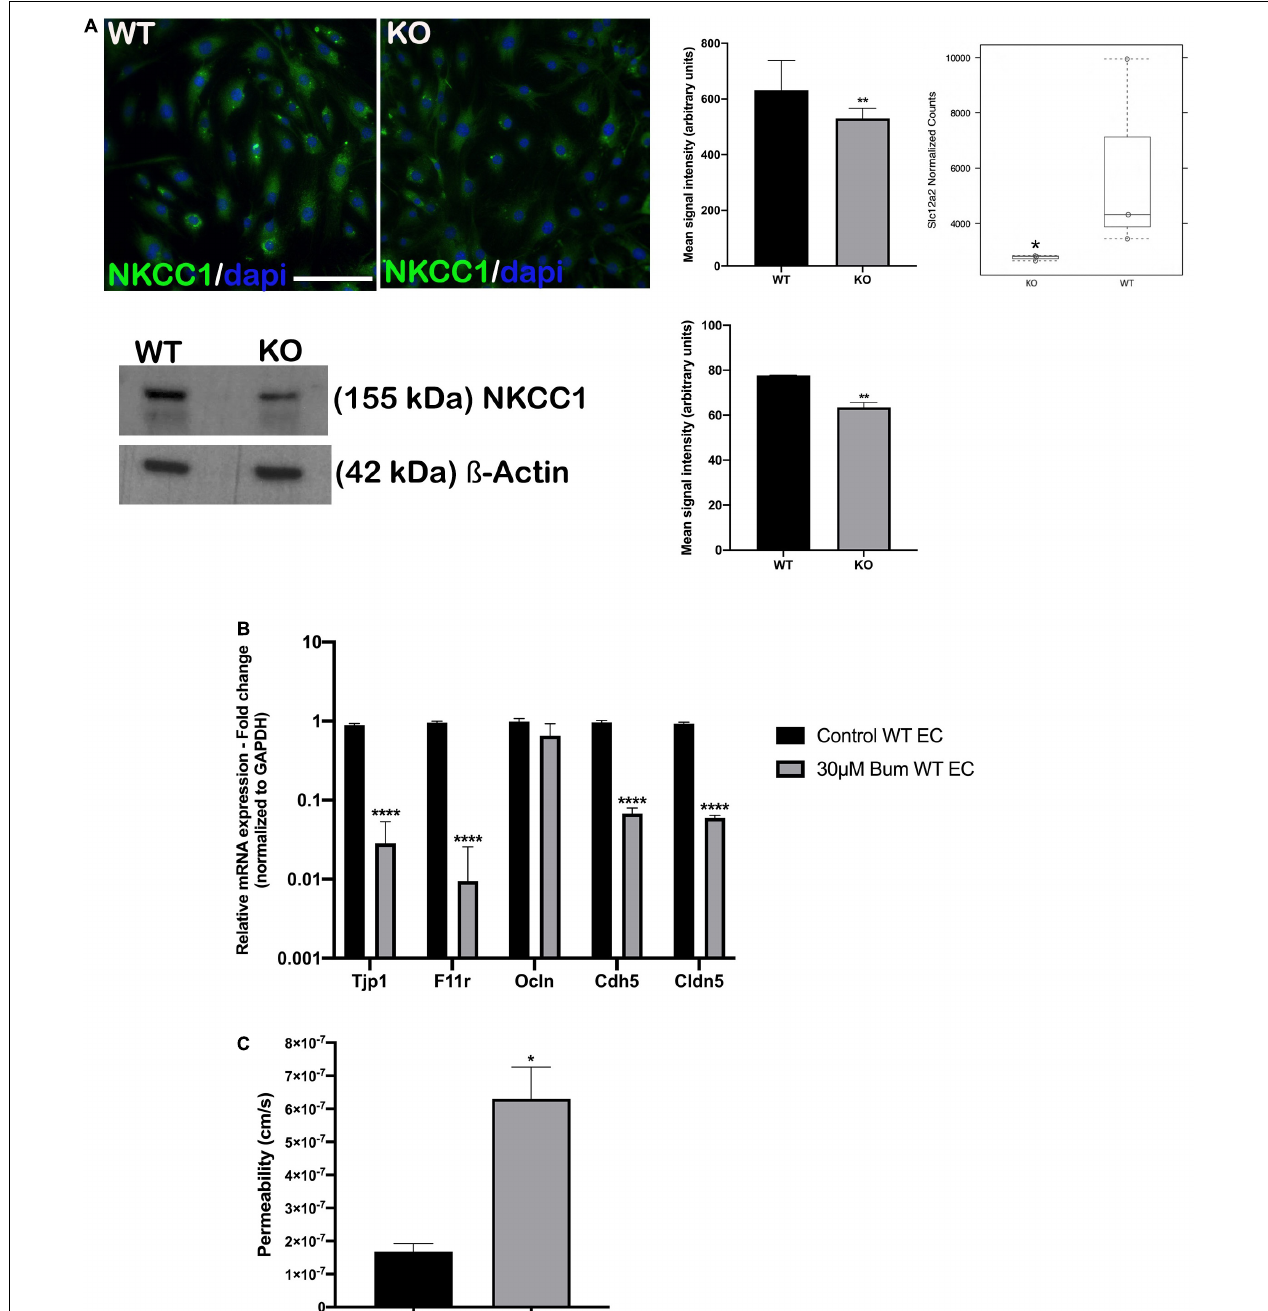
FIGURE 4 | NKCC1 inhibition influences endothelial permeability. (A, top left panel) endothelial cells immunostained with anti-NKCC1 antibodies show homogenous protein expression in a primary culture of wildtype (WT) and Nhe6 -knockout endothelial cells (KO). (A, middle panel) NKCC1 immunofluorescence signal quantification. Samples from five mice were pooled per phenotype and experiment; ( n = 3); Scale bar, 50 µ m. Data represent the mean (SD); ( n = 3); ** P < 0.01. (A, top right panel) In Nhe6 -knockout cells (KO), NKCC1 expression was downregulated, compared to WT cells. Data represent the mean ± SD; ( n = 3); * P < 0.05. (A, bottom left panel) Representative western blot image showing decreased NKCC1 protein presence in Nhe6 -knockout EC cell lysate. (A, bottom right panel) western bolt signal quantification. Each endothelial cell culture was obtained from three mice per phenotype and experiment, and individual experiments performed three times ( n = 3); Data represent the mean (SD); ** P < 0.01. (B) Relative mRNA expression of the junctional genes after inhibiting NKCC1 with 30 µ M bumetanide (bum) in WT endothelial cells (EC). Error bars represent the (SD); ( n = 3); **** P < 0.0001. (C) After inhibiting NKCC1 in WT ECs with 30 µ M bumetanide (30 µ M), permeability increased compared to untreated control cells (CTRL). Data represent the mean (SD); ( n = 3). * P < 0.05.